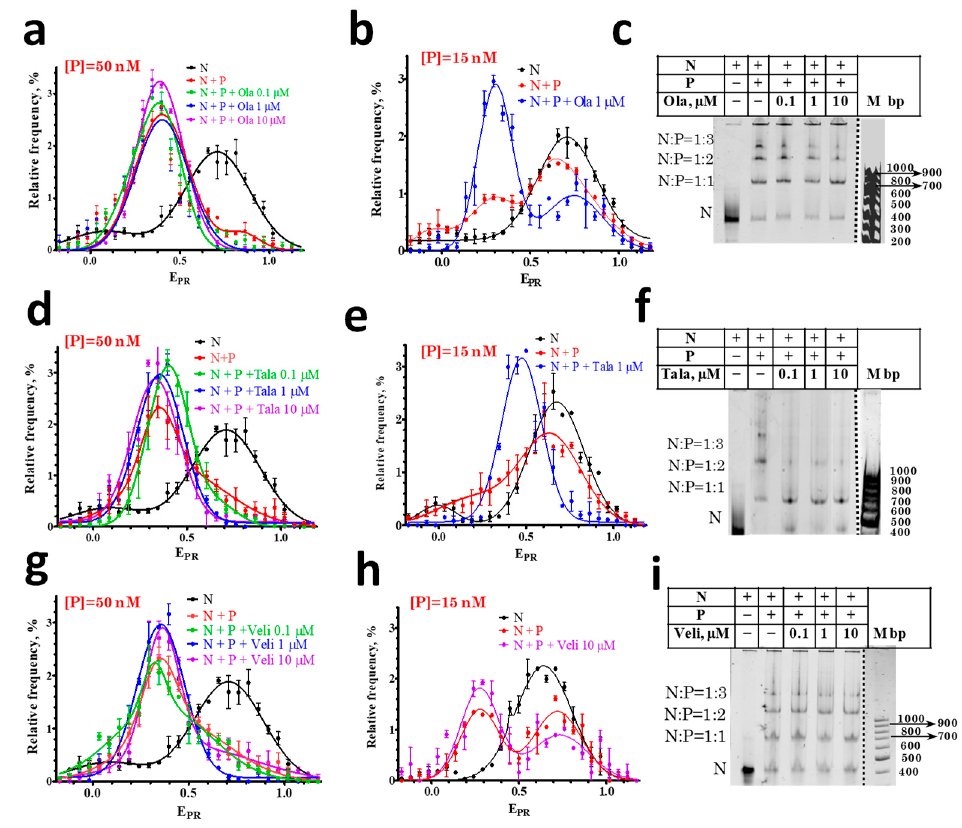
Figure 2. Effect of PARPi on the interaction of PARP1 with nucleosomes. ( a , b , d , e , g , h ) E PR profiles of nucleosomes (N) and nucleosome-PARP1 complexes (N+P) at different indicated concentrations of PARPi. Concentration of PARP1 ([P]) was 50 nM ( a , d , g ) or 15 nM ( b , e , h ). E PR profiles are presented as mean ± standard error of the mean ( n = 3). ( c , f , i ) EMSA data for nucleosomes and nucleosome-PARP1 complexes at the 50 nM concentration of PARP1 and different concentrations of PARPi. The stoichiometry of nucleosome-PARP1 complexes is indicated on the left. Some discrepancy between spFRET data in solution and in the gel, namely, appearance of small fraction of free nucleosomes ( c , f , i ) are most likely explained by a decreased stability of the complexes during electrophoresis.